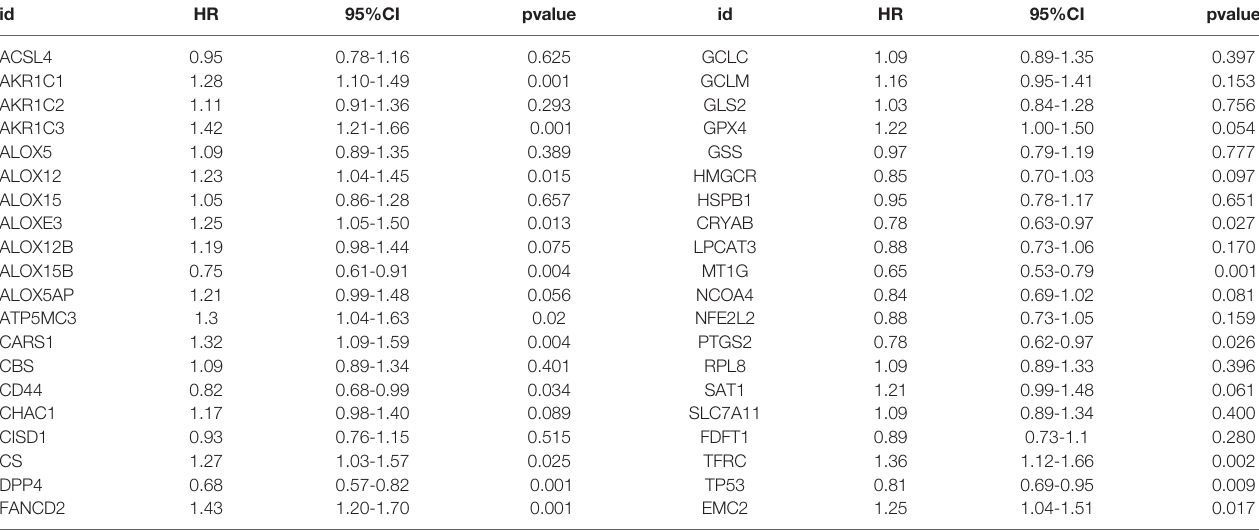
TABLE 1 | Univariate Cox regression results of 40 ferroptosis related genes.